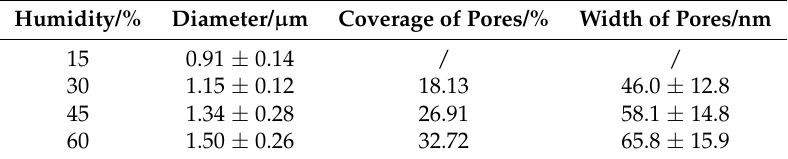
Table 2. Characterisation of fibres prepared under various levels of humidity.